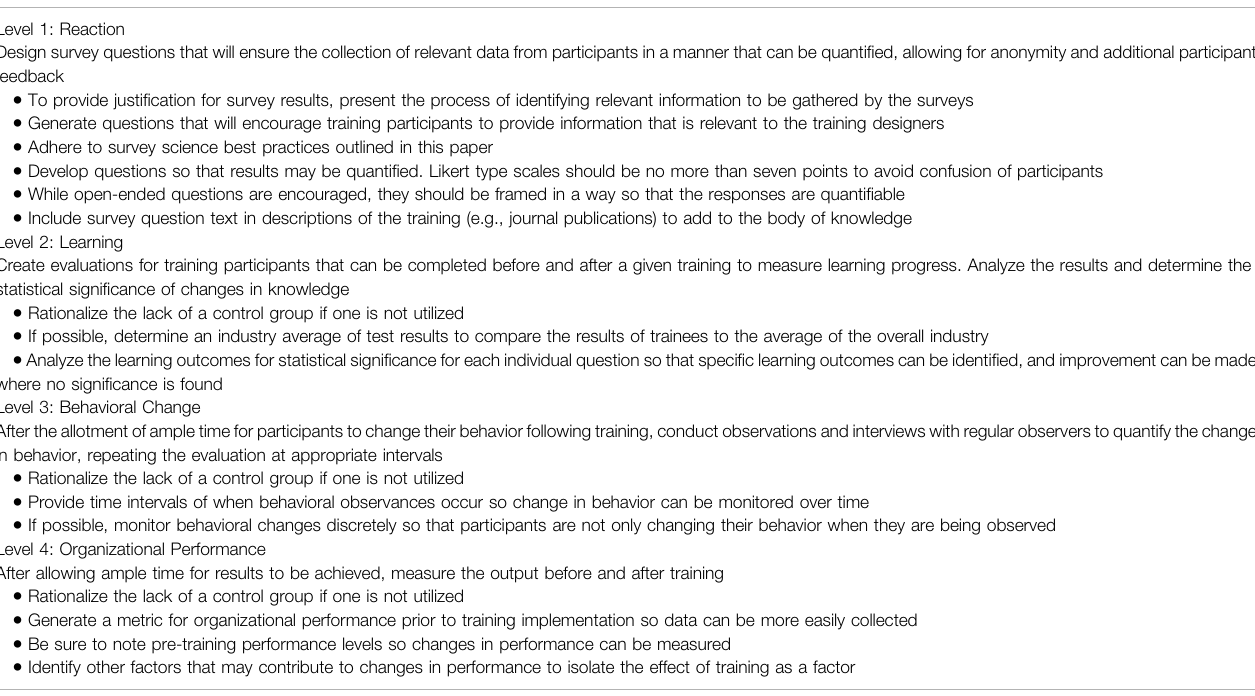
TABLE 4 | Framework for construction industry training